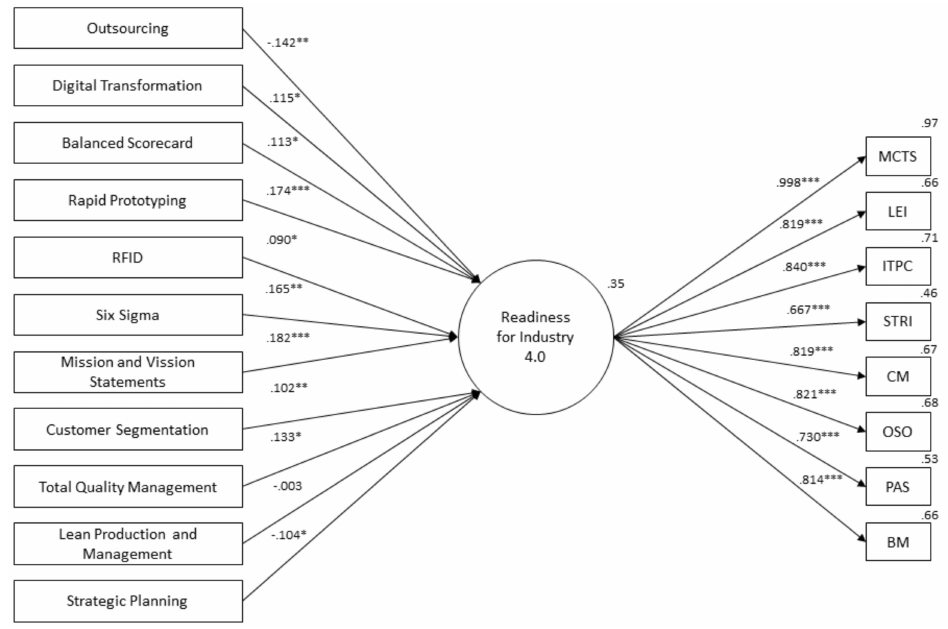
Figure 1. Structural equation model. Source: own elaboration; *** p < 0.001, ** p < 0.05, and * p < 0.01; sample size is